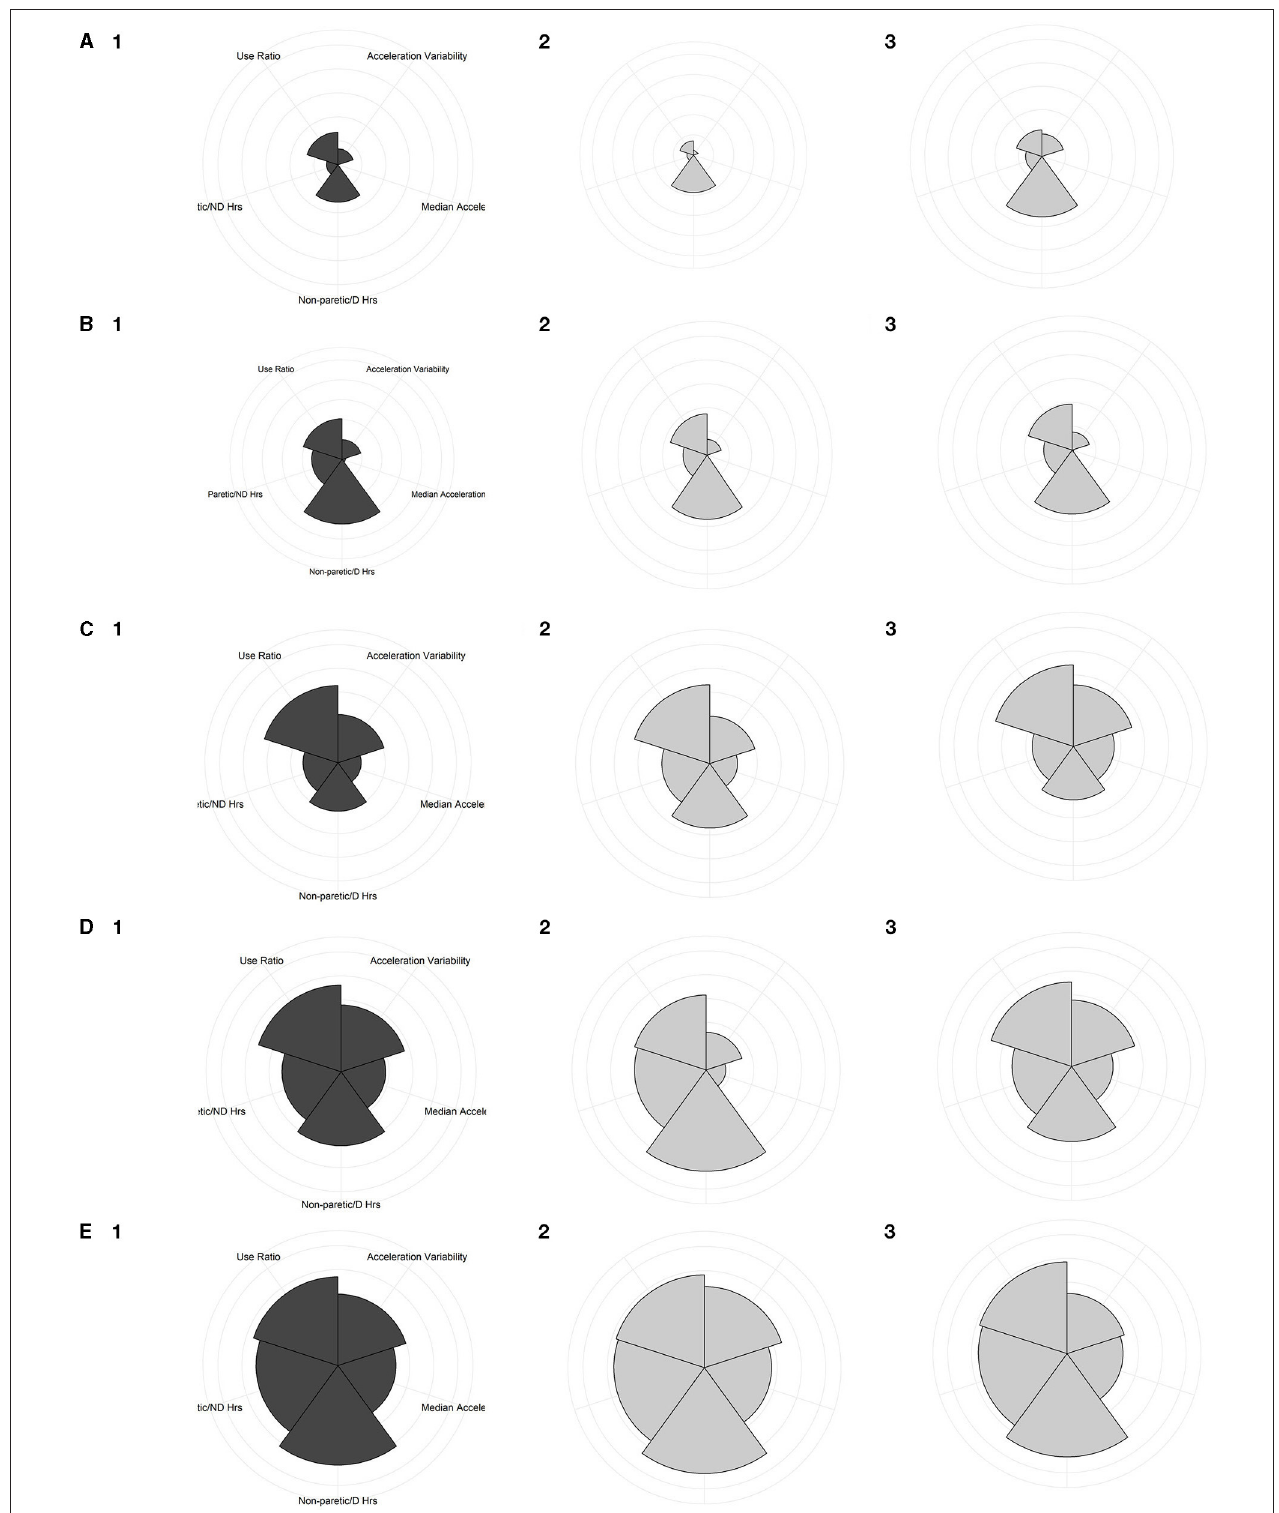
FIGURE 4 | Coxcomb charts of the five clusters, illustrating the contribution of the UL performance variables on a standardized scale. The first column plots group data, while the 2nd and 3rd columns plot individual participant examples. (A) Minimal Activity/Rare Integration cluster; (A1) group chart of people within this